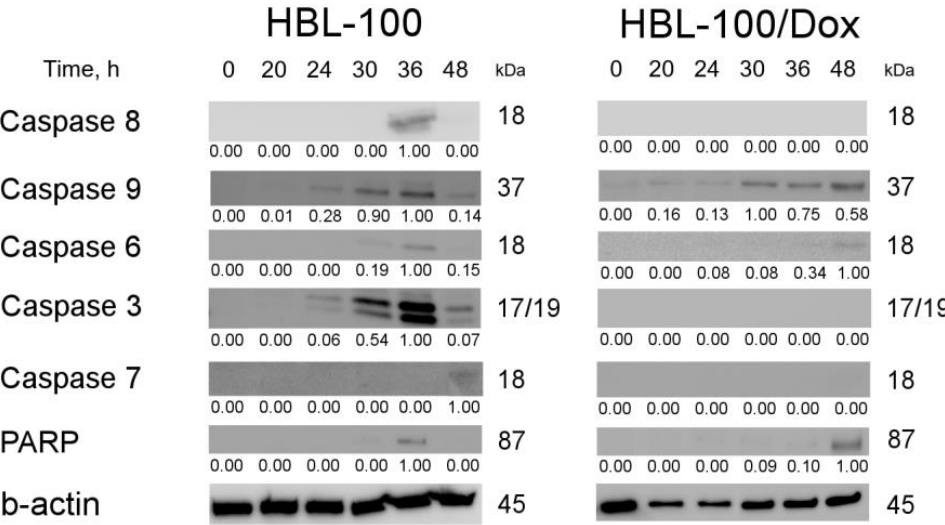
Figure 9. Western blot analysis of the expression of cytochrome c in HBL-100 and HBL-100/Dox cells after OA treatment for 16 h. β -Actin was used as loading control.